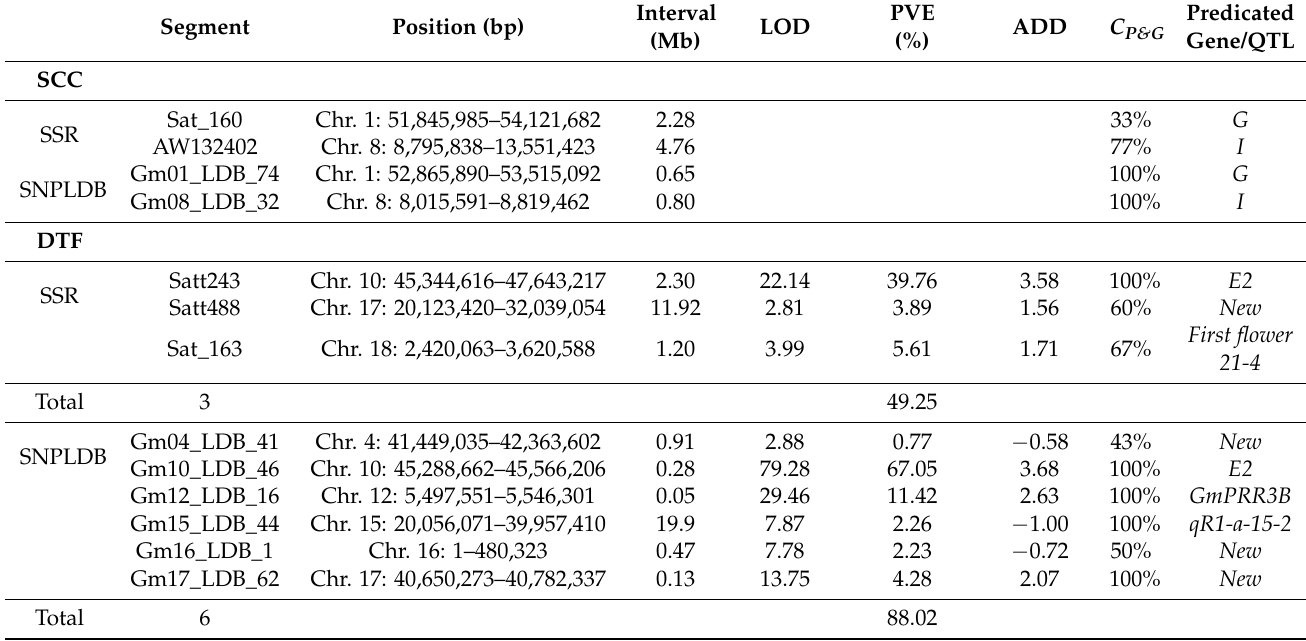
Table 2. Markers identified for SCC and DTF in SSR-map and